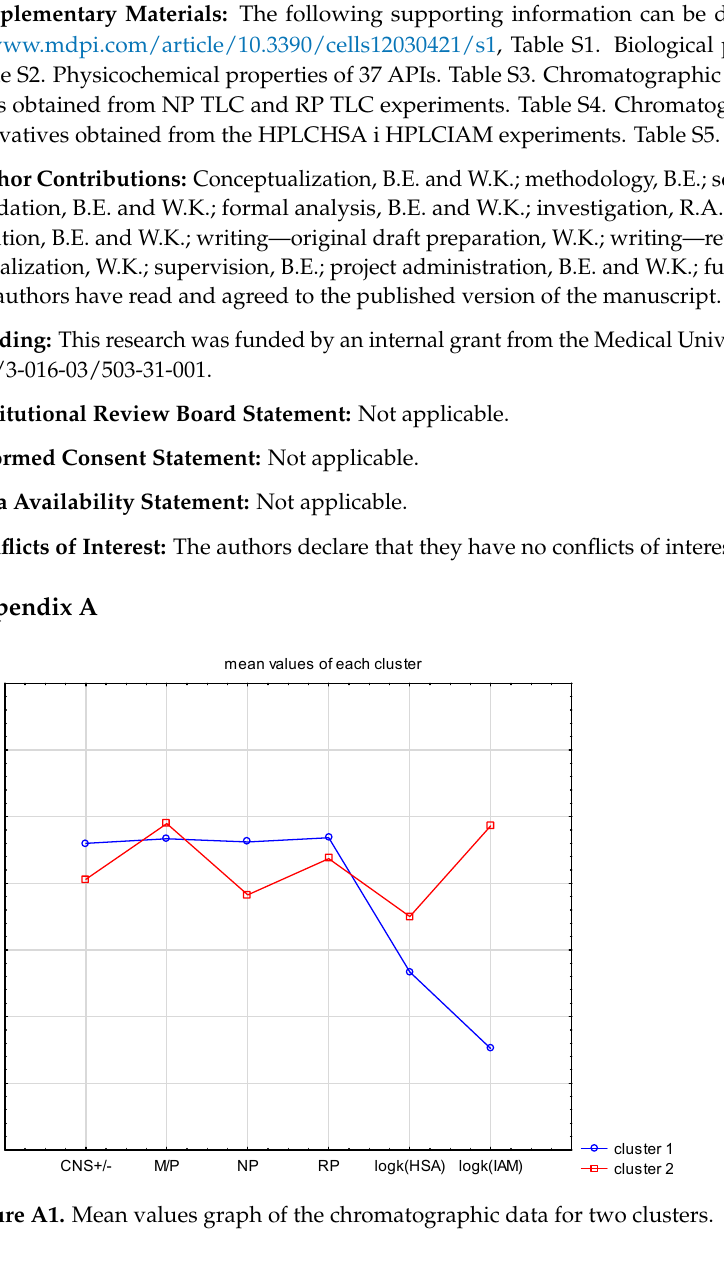
Table S2. Physicochemical properties of 37 APIs. Table S3. Chromatographic data and their deriva- tives obtained from NP TLC and RP TLC experiments. Table S4. Chromatographic data and their derivatives obtained from the HPLCHSA i HPLCIAM experiments. Table S5. Structures of 37 APIs.